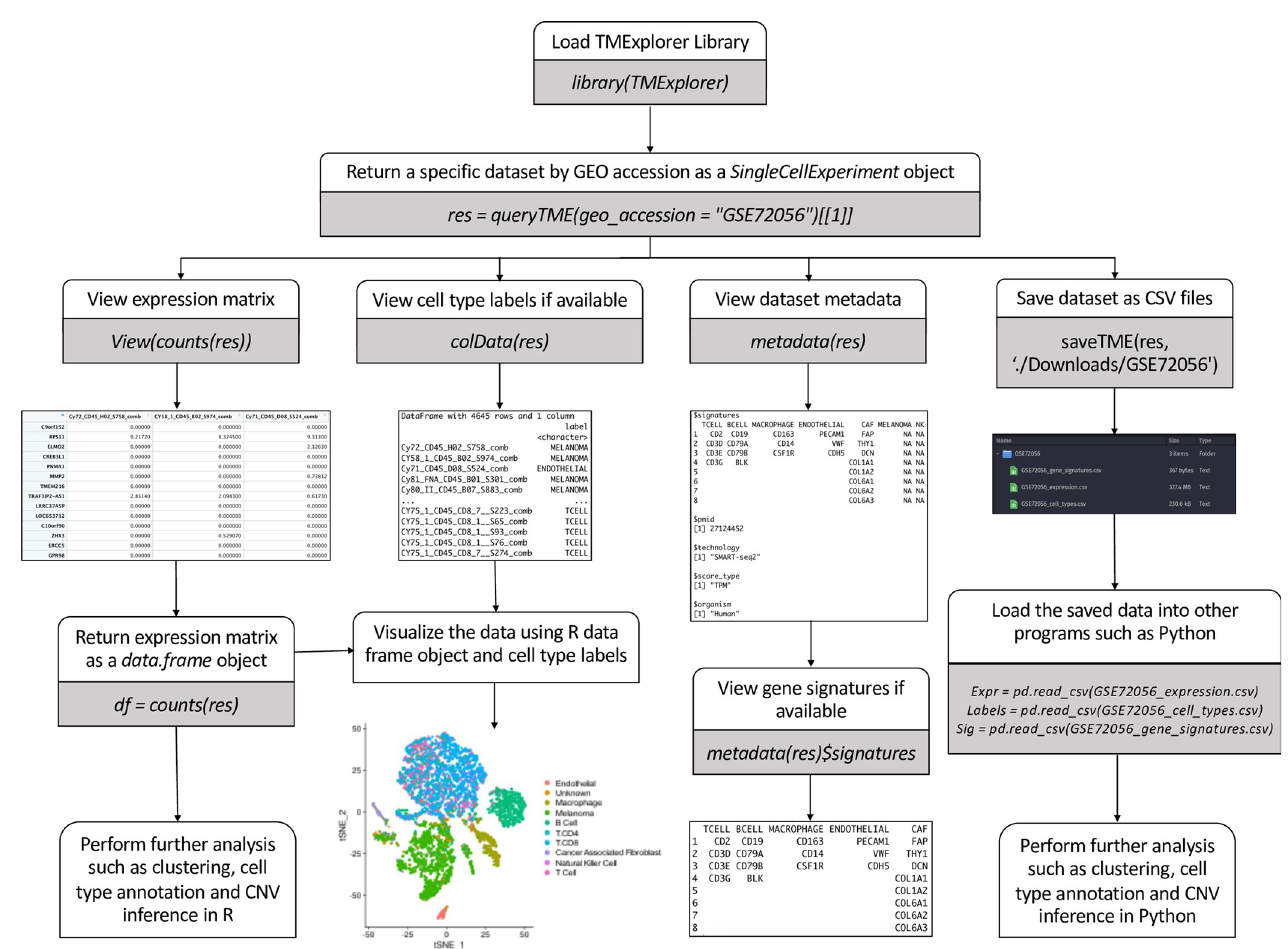
Fig 6. A flowchart of data query and analysis using TMExplorer. TMExplorer provides a search and analysis capability, where users can look up and return their datasets of interest, view the expression matrix, cell type labels and metadata including gene signatures (if available) and continue by either using R for data visualization and analysis, or save the datasets in CSV format to be analyzed by their programming language of choice (e.g. Python).